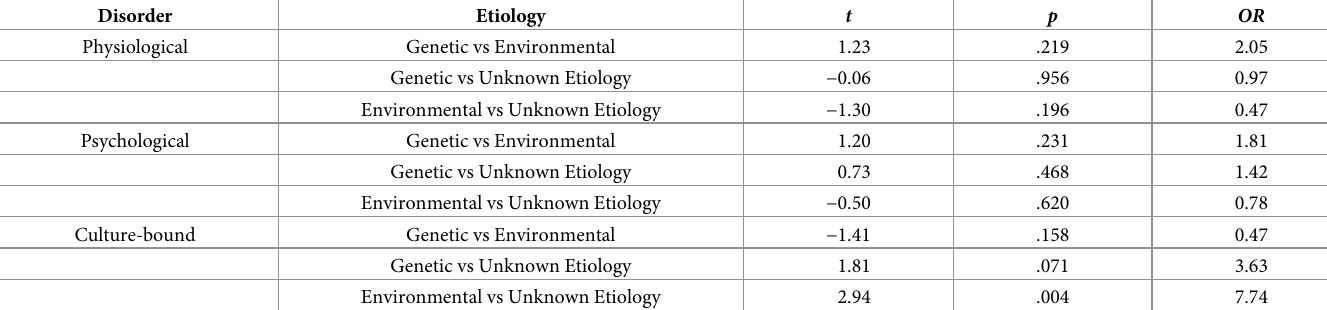
Table 4. Simple effects table at Disorder Type level for the probability of correct etiological recollections.